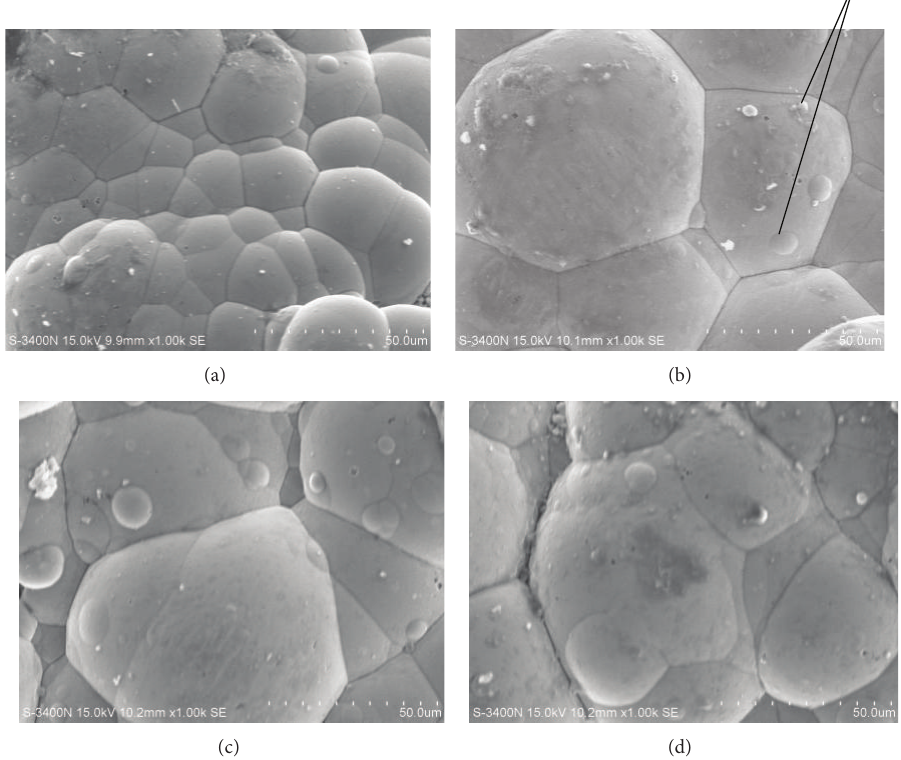
Figure 7: SEM micrograph (1000 × ) of electroless Ni–P coated with SLS surfactant on magnesium (Mg) composite reinforced with multiwall carbon nanotube (MWCNT) at various SiO concentrations: (a) 0.1%, (b) 0.5%, (c) 1%, and (d)